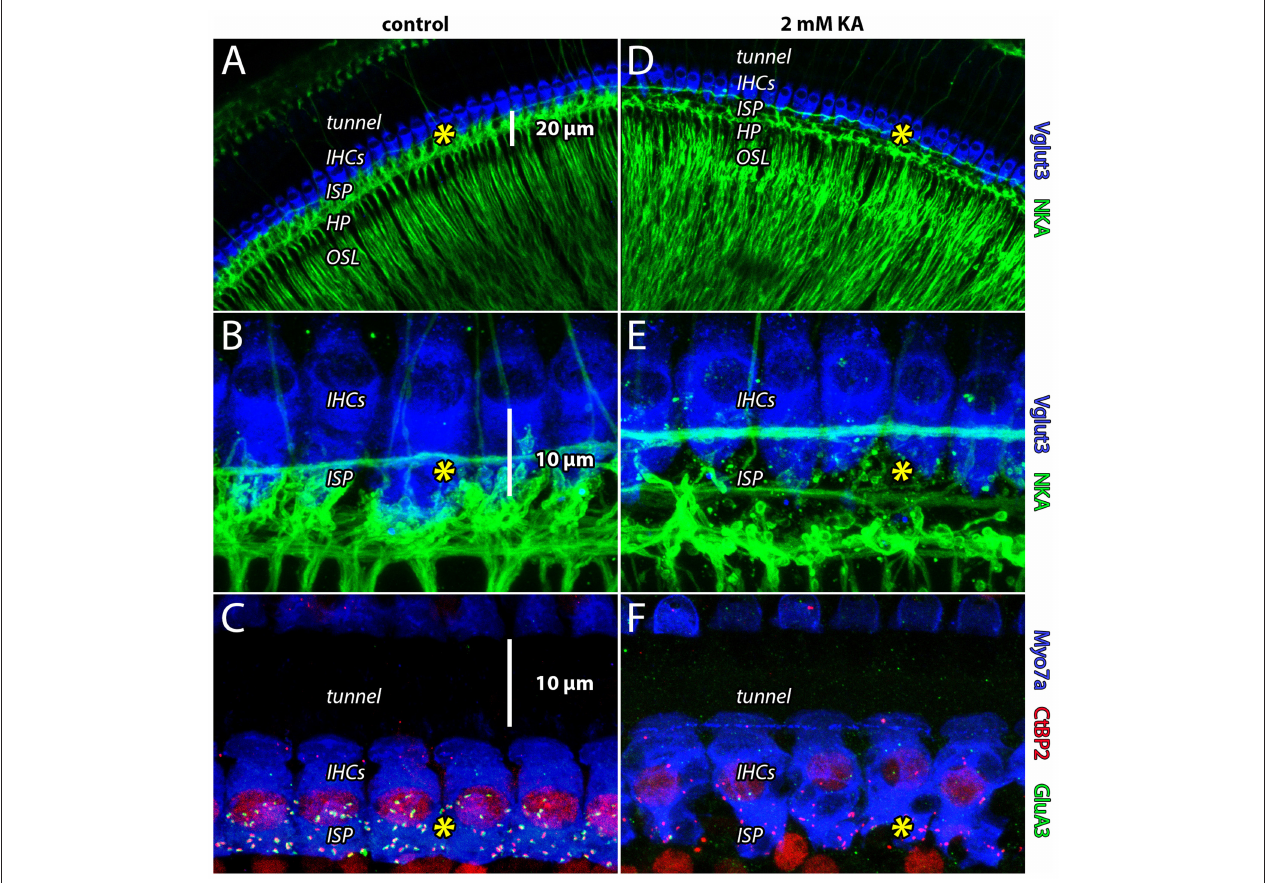
FIGURE 3 | Apical cochlear perfusion of kainic acid lesions ANF dendrites throughout the cochlear spiral. (A,B) Whole-mount preparation from the apical turn (turn four) of guinea pig cochlea. Inner hair cells (IHCs) are labeled with anti-Vglut3 (blue); Type-I auditory nerve fibers innervating IHCs in the inner spiral plexus (ISP) and tunnel-crossing medial olivocochlear efferent neurons are labeled with anti-Na + / K + -ATPase (green). In all panels, yellow asterisk indicates location of ribbon synapses in the ISP. (C) Whole-mount preparation from the basal turn (turn one). In control samples, presynaptic ribbons (anti-CtBP2, red) of IHCs (anti-Myosin7a, blue) are paired with postsynaptic AMPA receptors (anti-GluA3, green) in the ISP. Anti-CtBP2 also labels cell nuclei. Perfusion of artificial perilymph into scala tympani from the cochlear apex resulted in images like those taken from naïve controls, showing dense innervation in the neuropil of the organ of Corti under IHCs (in the inner spiral plexus, ISP). (D–F) Disintegration of synapses from the cochlear apex (turn four) to the base (turn one) confirms the apical perfusion solution accessed the scala tympani all the way down the length of the